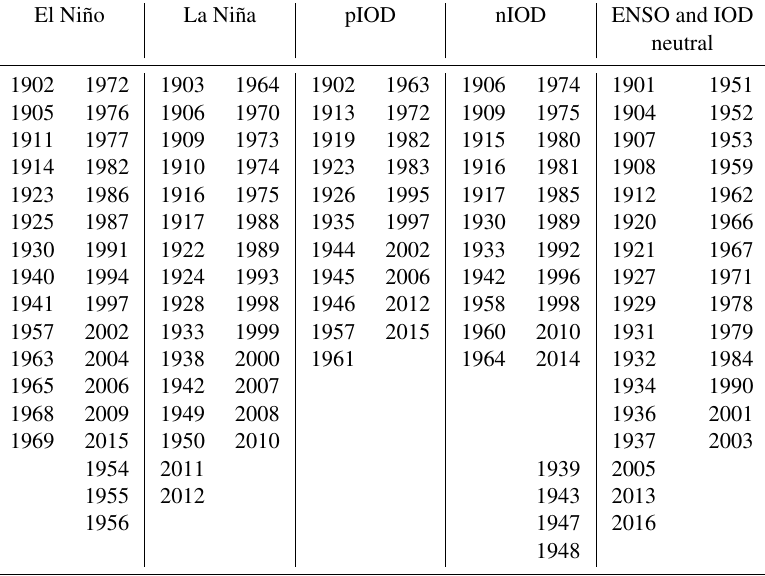
Table B2. Years from 1901–2017 identified as El Niño, La Niña, positive Indian Ocean Dipole (“pIOD”), negative Indian Ocean Dipole event (“nIOD”), and remaining years that are both ENSO- and IOD-neutral based on the analysis by the NOAA (for the ENSO events) and Bureau of Meteorology (IOD events). Note that we define a year as starting in July and ending in June so that for example the 1991–1992 El Niño appears in this table as the 1991 El Niño. We follow Ummenhofer et al. (2011), the Bureau of Meteorology Australia (Bureau of Meteorology, Commonwealth of Australia, 2016), and the National Weather Service Climate Prediction Center (Climate Prediction Center Internet Team, 2021) for the identification of ENSO and IOD